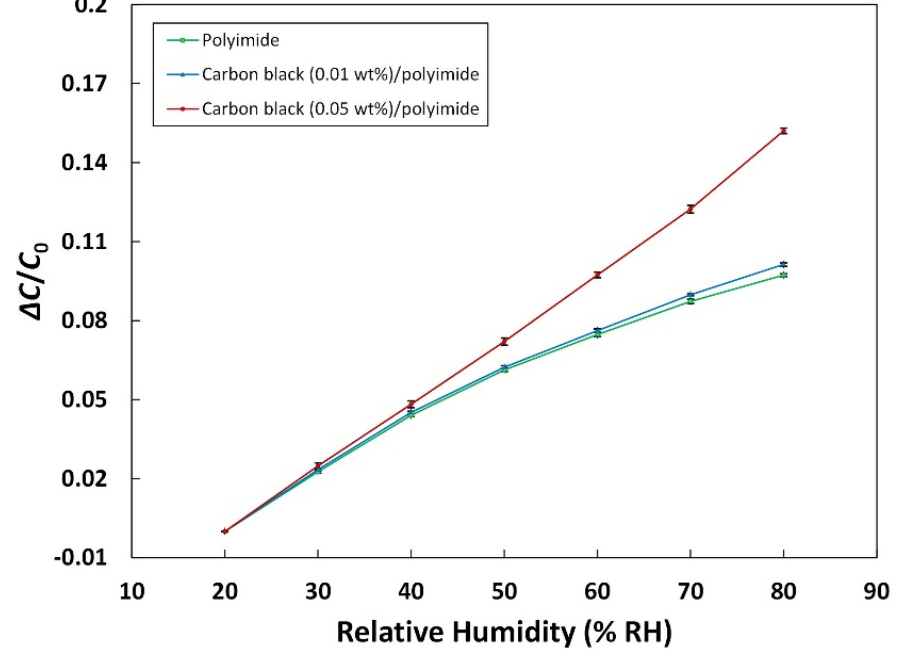
Figure 4. Sensitivity of the humidity sensors.